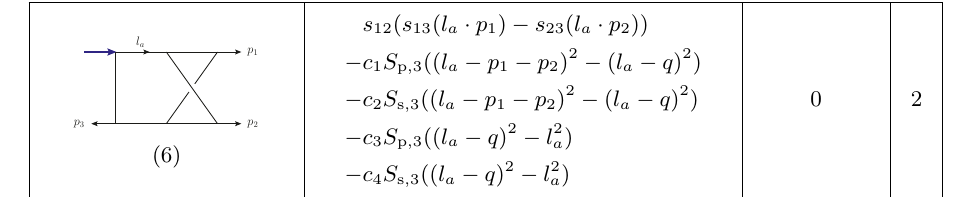
Table 2. CK-dual factors of the two-loop form